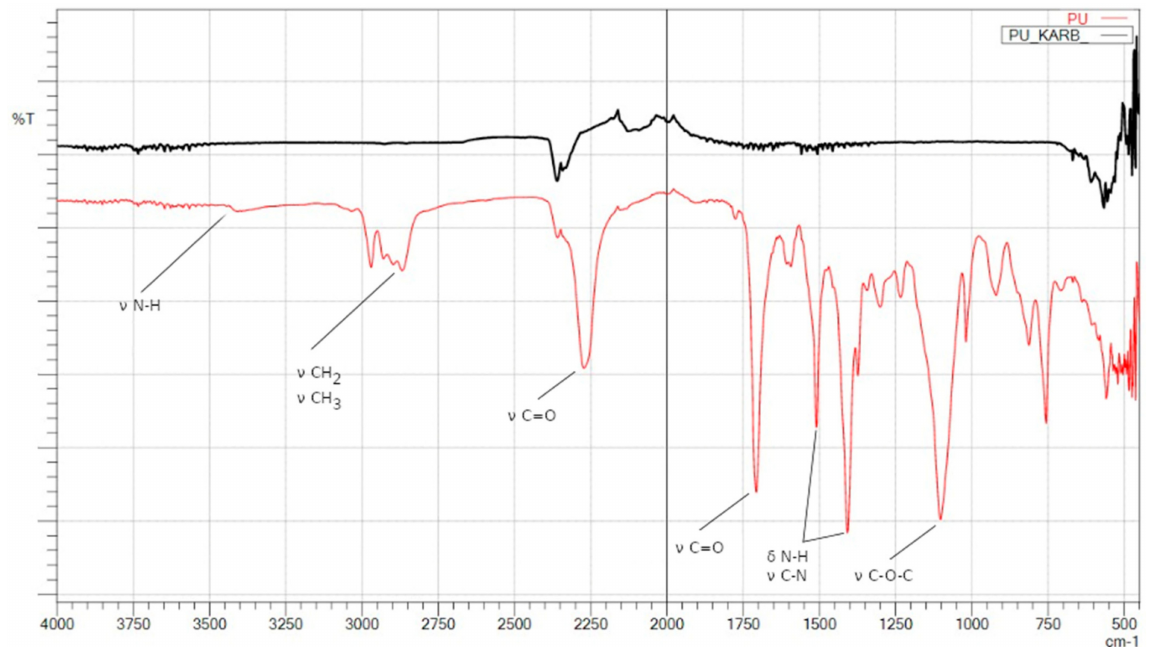
Figure 4. FTIR spectra of polyurethane (PU foam—red line), polyurethane after carbonization (PU KARB—black line).